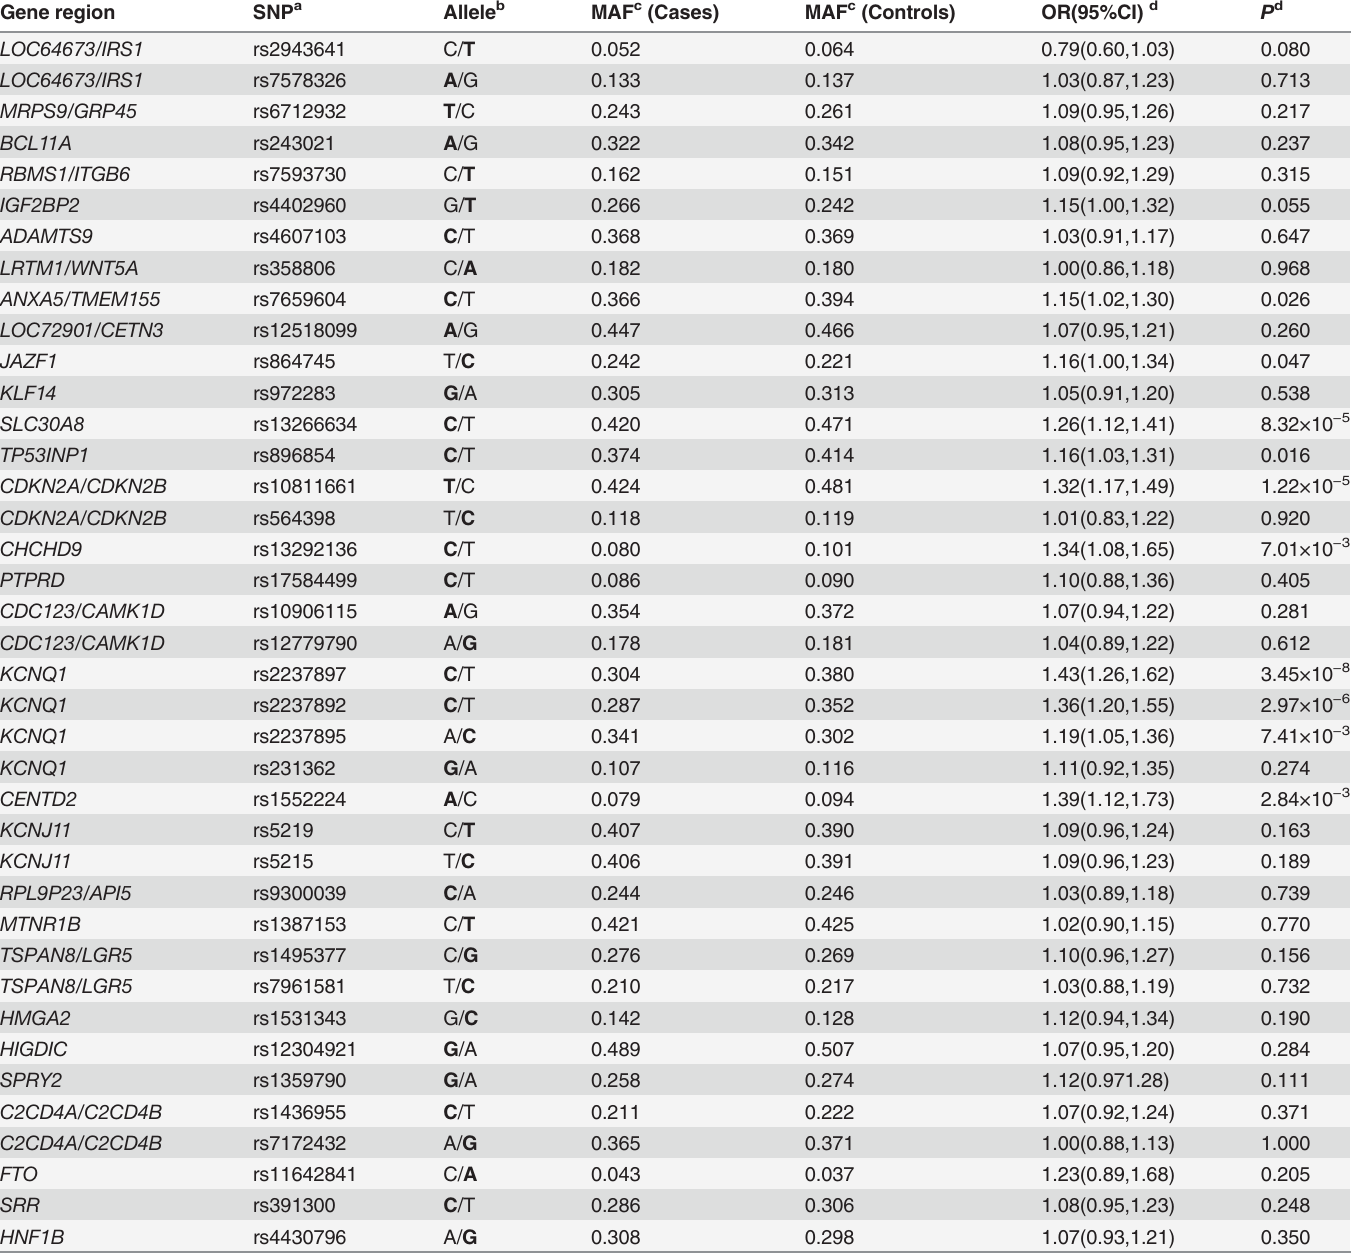
Table 1. Association between 39 SNPs from 30 loci and type 2 diabetes in the discovery